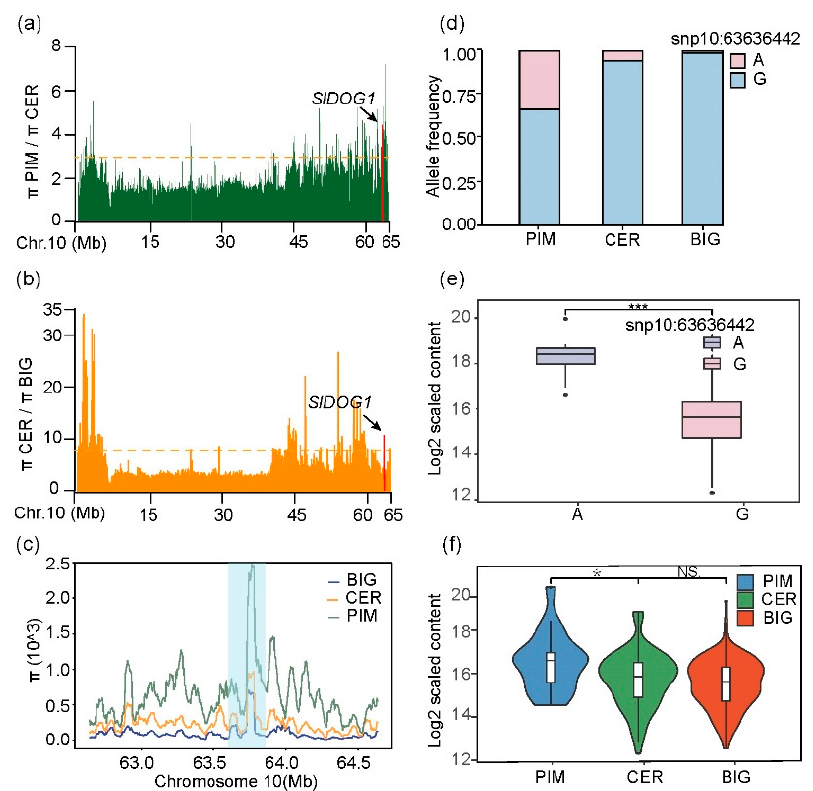
Figure 5. Analysis of variation in SlDOG1 in tomato. ( a – c ): Nucleotide diversity ratios between PIM and CER ( a ) and between CER and BIG ( b ) on chromosome 10. The orange dashed horizontal lines indicate the top 10% threshold for all of chromosome 10 (1.82 pPIM/pCER for domestication and 4.27 pCER/pBIG for improvement). The red color indicates the position of SlDOG1 in selective sweeps. ( d ): Allele frequency distribution for two SlDOG1 major alleles (A or G) in PIM, CER, and BIG. ( e ): Analysis of natural variation associated with SlDOG1 in tomato. Box plots of tomatidine content for each SlDOG1 allele. In the box plots, the middle line indicates the median, the box indicates the interquartile range, the whiskers indicate the minimum and maximum values, and the outer dots indicate any outliers. Significant differences were identified using Student’s t -tests. ( f ): Violin plots of tomatidine content in PIM, CER, and groups. Data were from three independent experiments and expressed as means ± SD. ( n = 3). The differences were analyzed in two tailed comparisons with the control, and * p < 0.05; *** p < 0.01; ns: no significant difference, p > 0.05 in the student’s t -test.